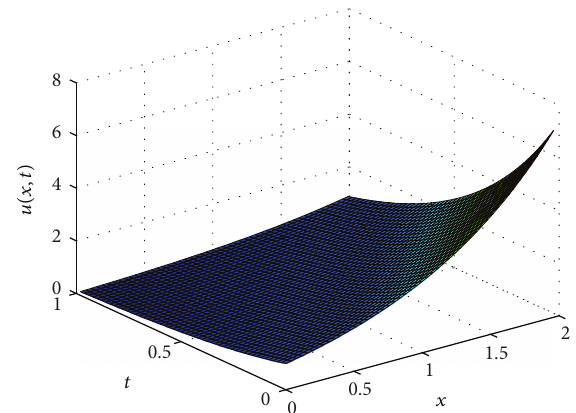
Figure 4: Depiction of solution 𝑢(𝑥,𝑡) in the domain 𝑥 ∈ [0, 2] and 𝑡 ∈ [0, 1] for Examples 1 and 3.